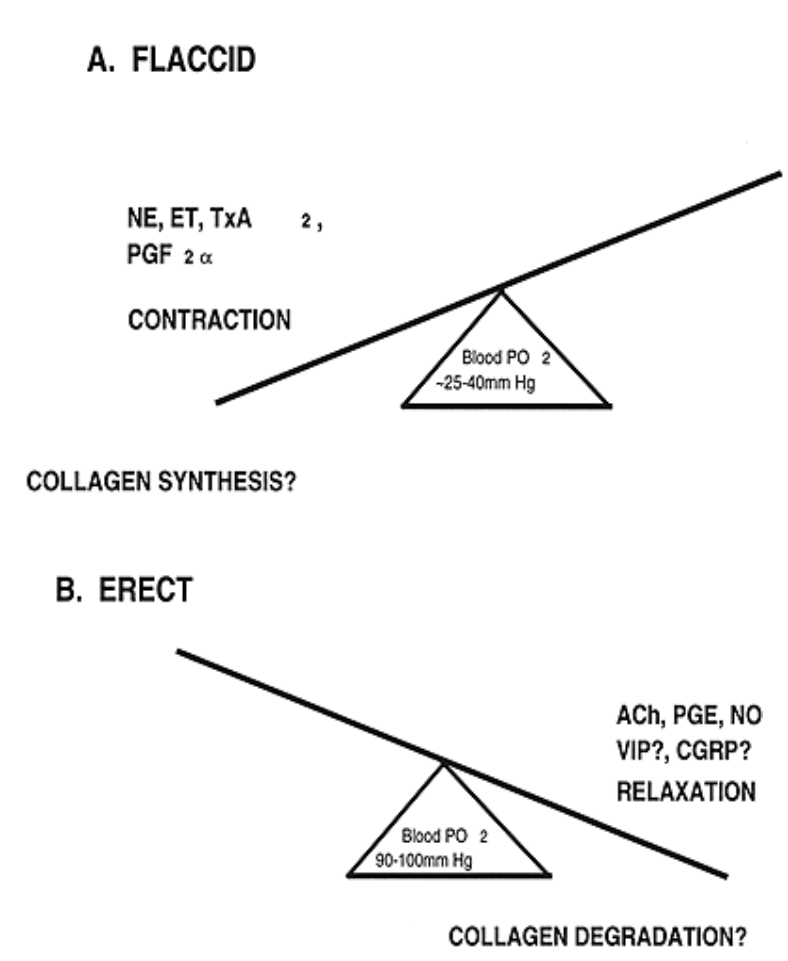
FIGURE 1 . The seesaw of erectile (dys)function. Panel A: At flaccidity, corpus cavernosal blood PO2 is low (25-40mm Hg), the trabecular smooth muscle of the lacunar spaces contracted. It is our hypothesis that these conditons favor the production of growth factors, cytokines, and vasoactive factors which favor connective tissue synthesis. Panel B: During erection, corpus cavernosal blood PO2 increases and plateaus at 90-100mm Hg and the trabecular smooth muscle of the lacunar spaces relaxes. We further hypothesize that these conditions favor connective tissue degradation. It is the sum of both processes which lead to the trabecular smooth muscle/connective tissue balance (Adapted from Reference